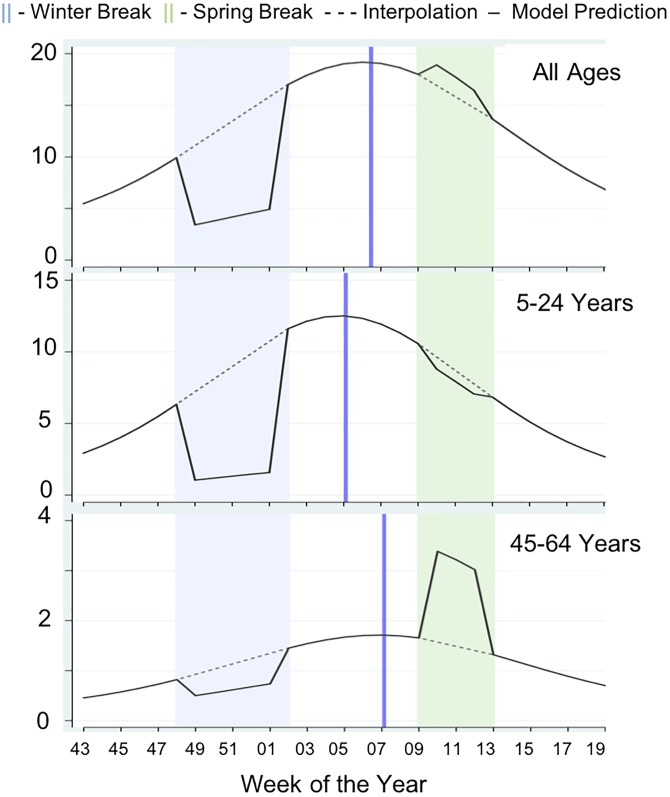
Seasonal signatures of weekly tests for time periods surrounding the Winter and Spring university school breaks for the all ages, 5–24 years and 45–64 years age groups (panels A, B and C, respectively).